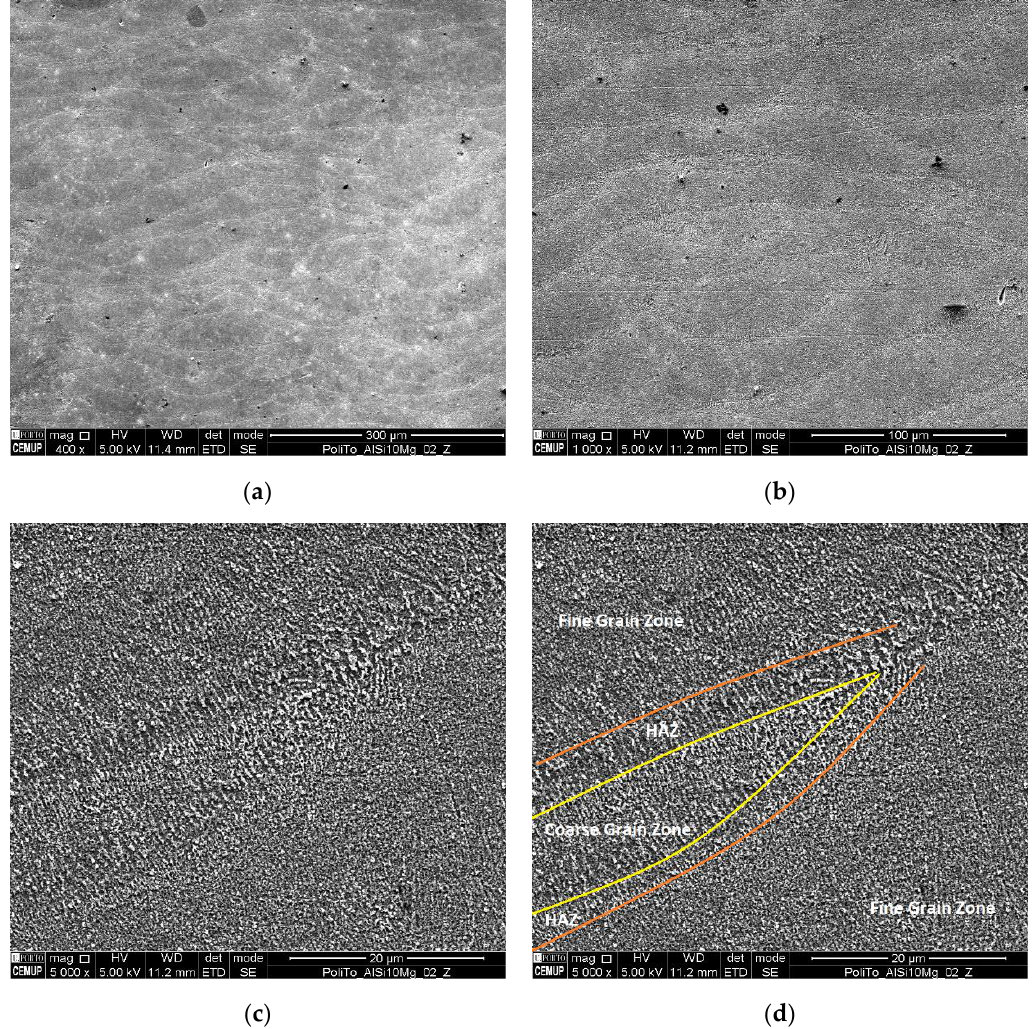
Figure 5. Microstructural Images Provided via SEM Analysis of Z Plane of Sample; ( a ) Overview of an Area at 400× Magnification, with Visual Building Up of Layers; ( b ) Exact Same Area at 1000× Magnification; ( c ) 5000× magnification close up; ( d ) identification of morphological areas seen in Figure 5c.